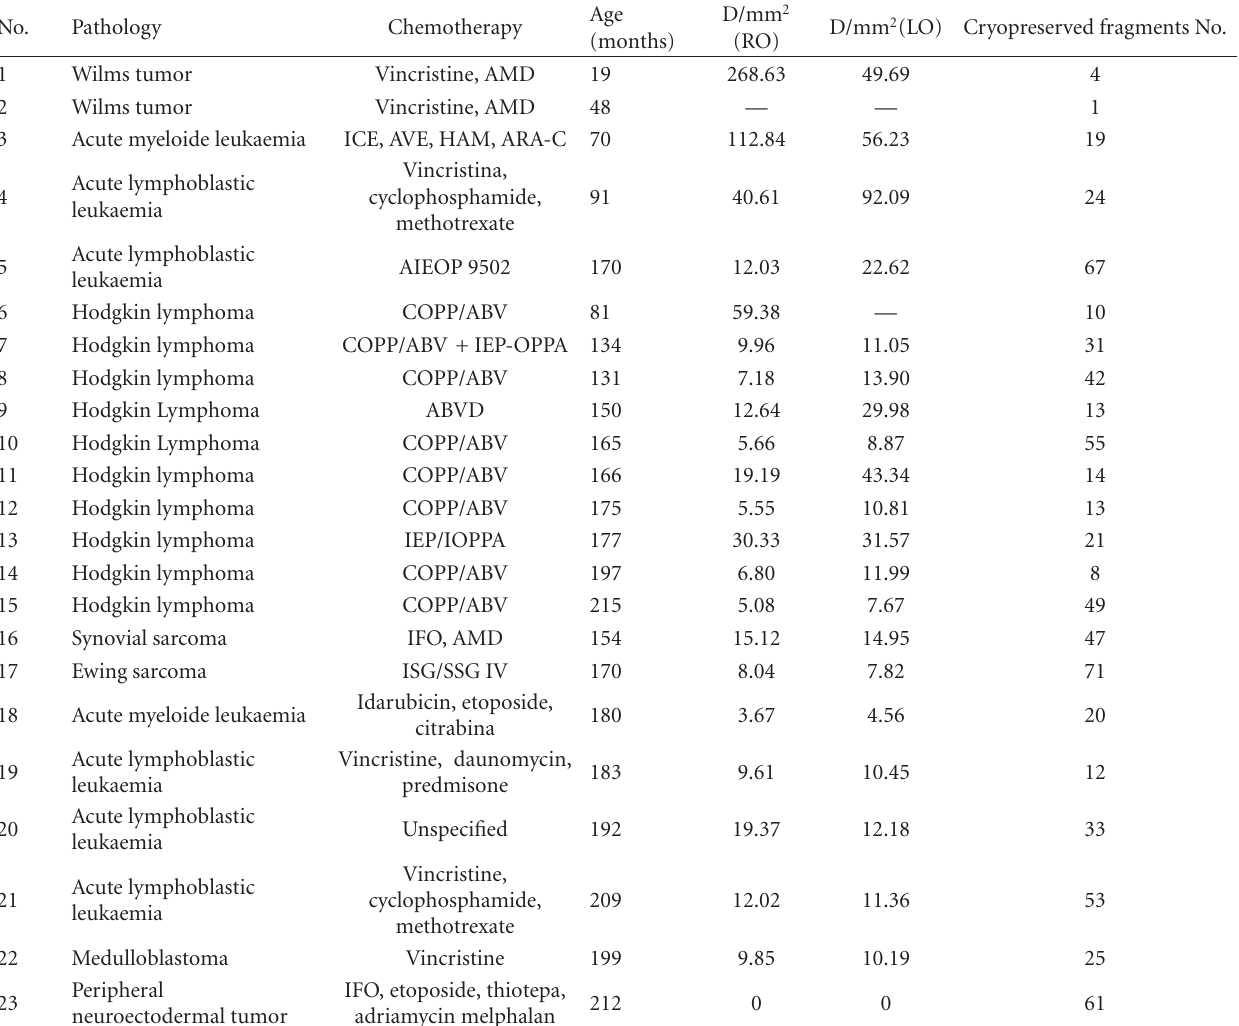
Table 3: Characteristics of the post-chemotherapy patients who had ovarian tissue